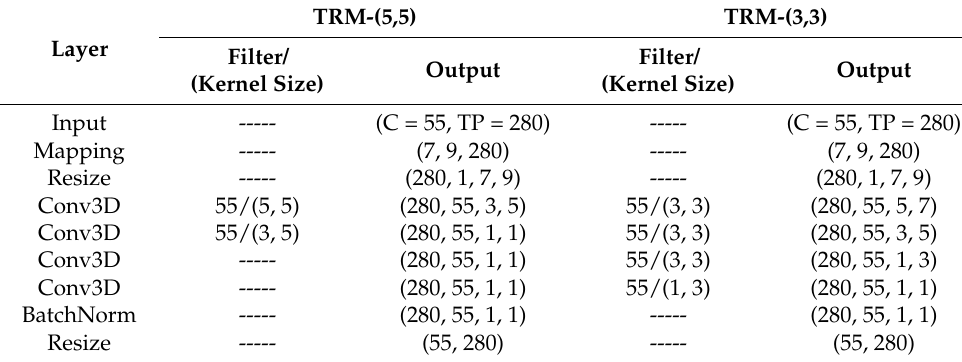
Table A1. The TRM architecture used on the